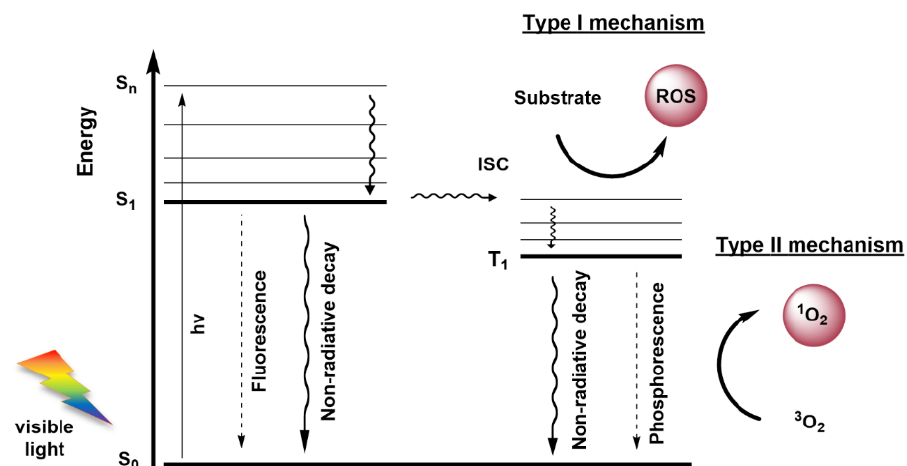
Figure 1. Representation of modified Jablonski diagram.